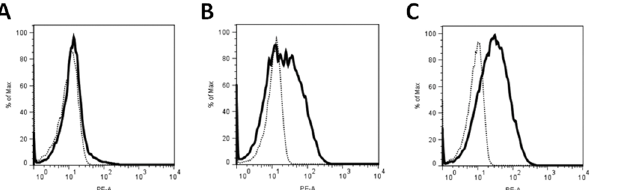
Fig 4. Expression levels of α SMA ex vivo , after MSCs expansion and myogenic differentiation in vitro . (A) Mononuclear cells were directly isolated from bone marrow ex vivo and assessed for expression of α SMA by flow cytometry. Viable cells were gated (SSC/FSC), CD45 + cells were excluded, and expression of α SMA was recorded in the cytoplasm of the CD45 - CD271 + fraction of the mononuclear cells. The histogram represents α SMA in the cytoplasm of CD271 + cells (solid line) compared to the unstained controls (dotted line). (B) MSCs were expanded in GMP-compliant expansion medium and then assessed for expression of α SMA in the cytoplasm of the cells. Viable cells were gated (SSC/FSC) and α SMA + cells were recorded (solid line). The dotted histogram represents the unstained controls. The broad profile of the histogram indicates that a large portion of MSCs express α SMA after expansion and prior to induction of differentiation (27% of MSCs were positive, MFI of 38). (C) After expansion in GMP-compliant expansion medium MSCs were differentiated for 14 days. Then expression of α SMA in the cytoplasm of differentiating MSCs was explored (solid line). The histogram indicates that more cells contain α SMA after differentiation (27% of MSCs were positive, MFI of 42, right panel). The dotted lines represent unstained controls.